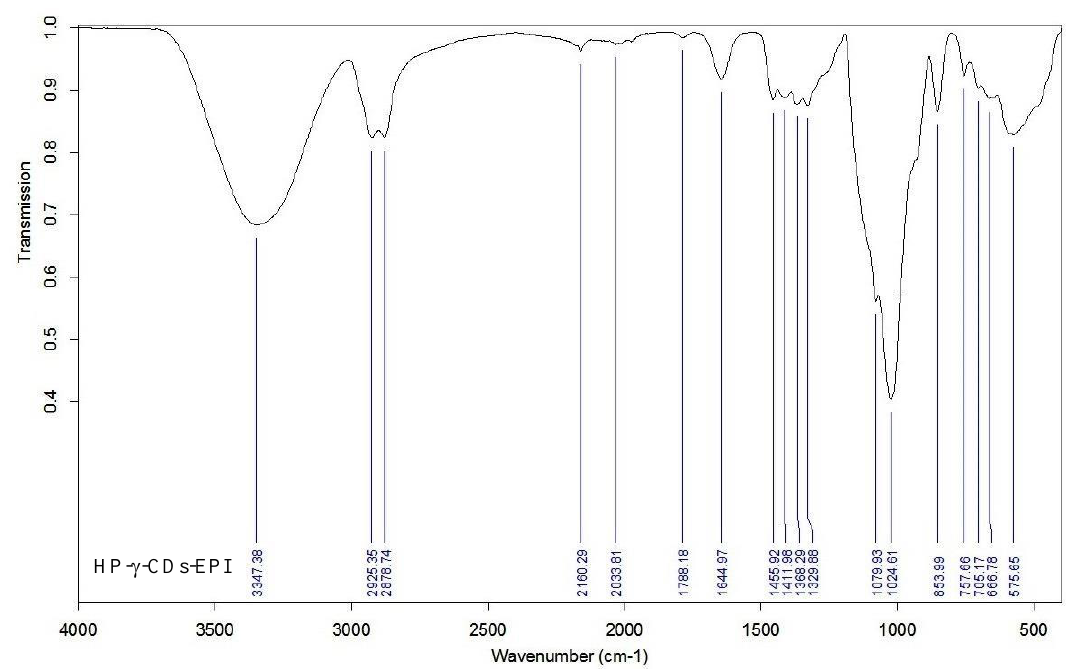
Figure 2. Fourier transform infrared (FTIR) spectra for the native and modified CDs and the crosslinked polymers.